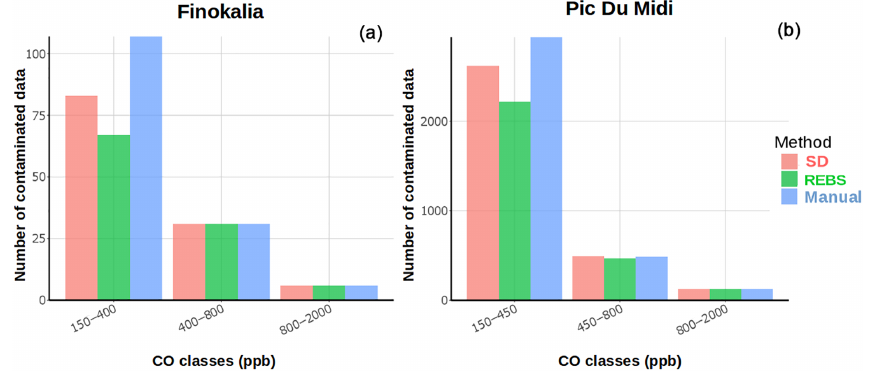
Figure 7. Number of flagged CO measurements using manual method (blue), SD method (red) and REBS method (green) for Finokalia (a) and Pic Du Midi (b) . Table 6. Classification of the number of hours in which the SD method filtered at least 1min data point for CO, CO 2 , and CH 4 at the four sites. The intervals represent the differences between filtered and the non-filtered time series averaged at a hourly scale in ppm for CO 2 and (ppb) for CO, and CH 4 . The values in brackets represent the percentages of the impacted hours on the whole time series. CO 2